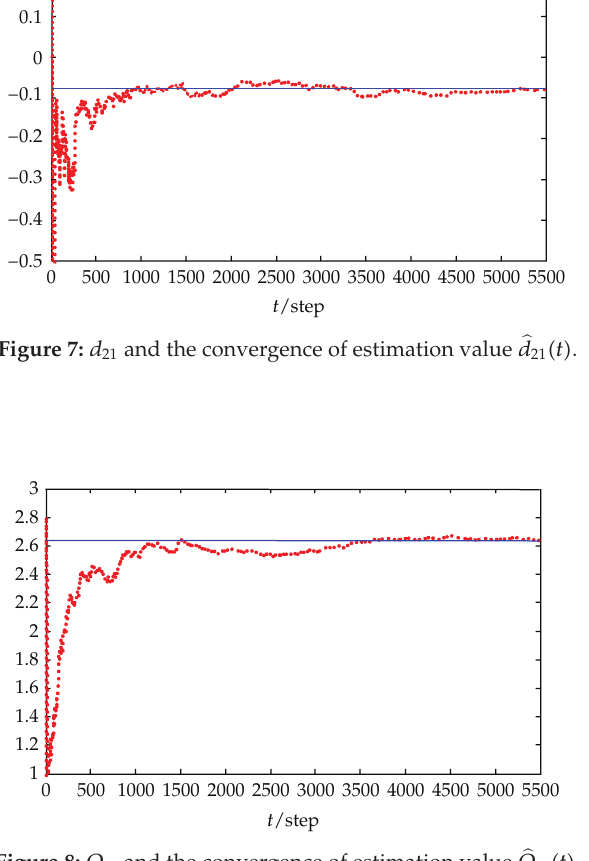
and the convergence of estimation value 2